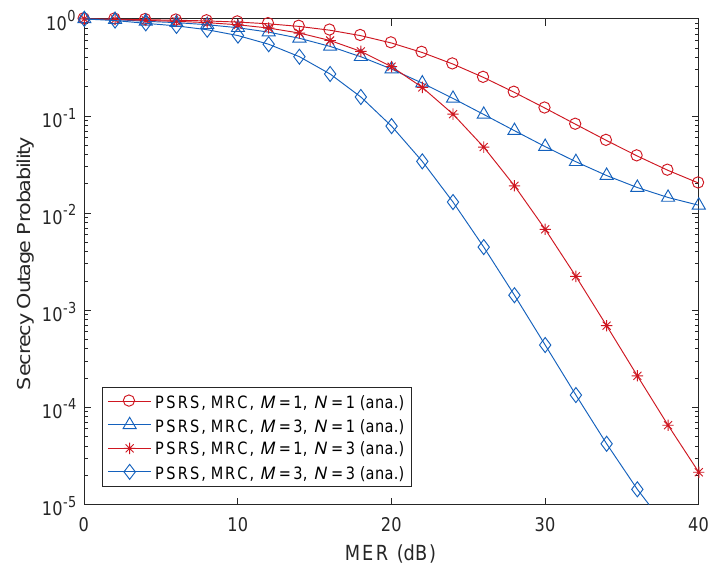
Figure 8. Illustration of the impact of the number of sources, M , and the number of relays, N , on the secrecy outage probability as a function of the main-to-eavesdropper ratio (MER), where d SR = 0.5, SNR = 30 dB and R th = 3 bits/s/Hz.